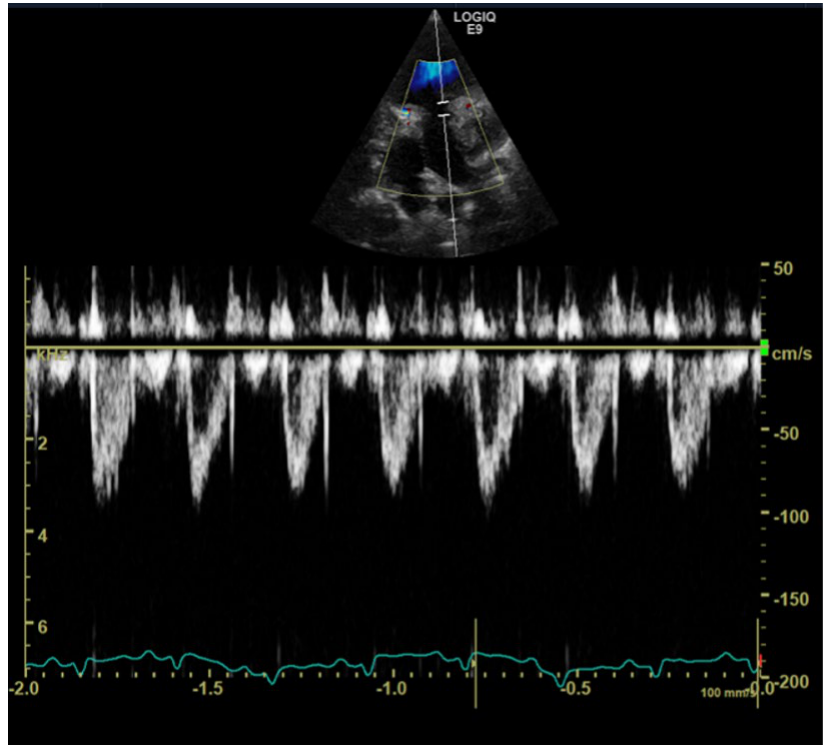
Figure 4. Transthoracic left apical window modified 4–chamber view optimized for the right ventricular outflow tract. Doppler (color and spectral) examination shows a pulmonary artery profile with type II profile but normal peak blood flow velocity, suggesting increased pulmonary artery pressures.